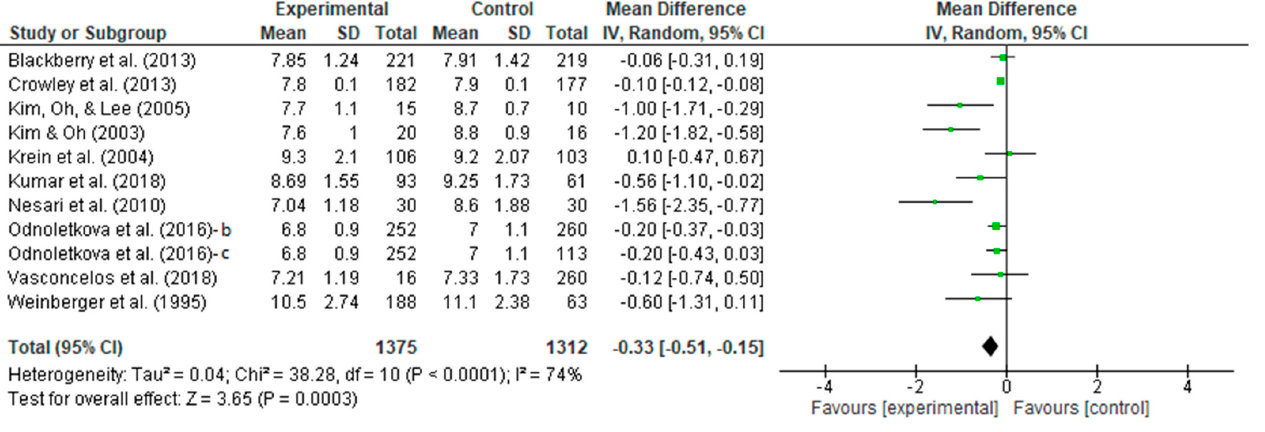
Figure 4. Forest plot intervention vs. control of telecoaching in achieving a HbA1C outcome [7,12,13,15–22].